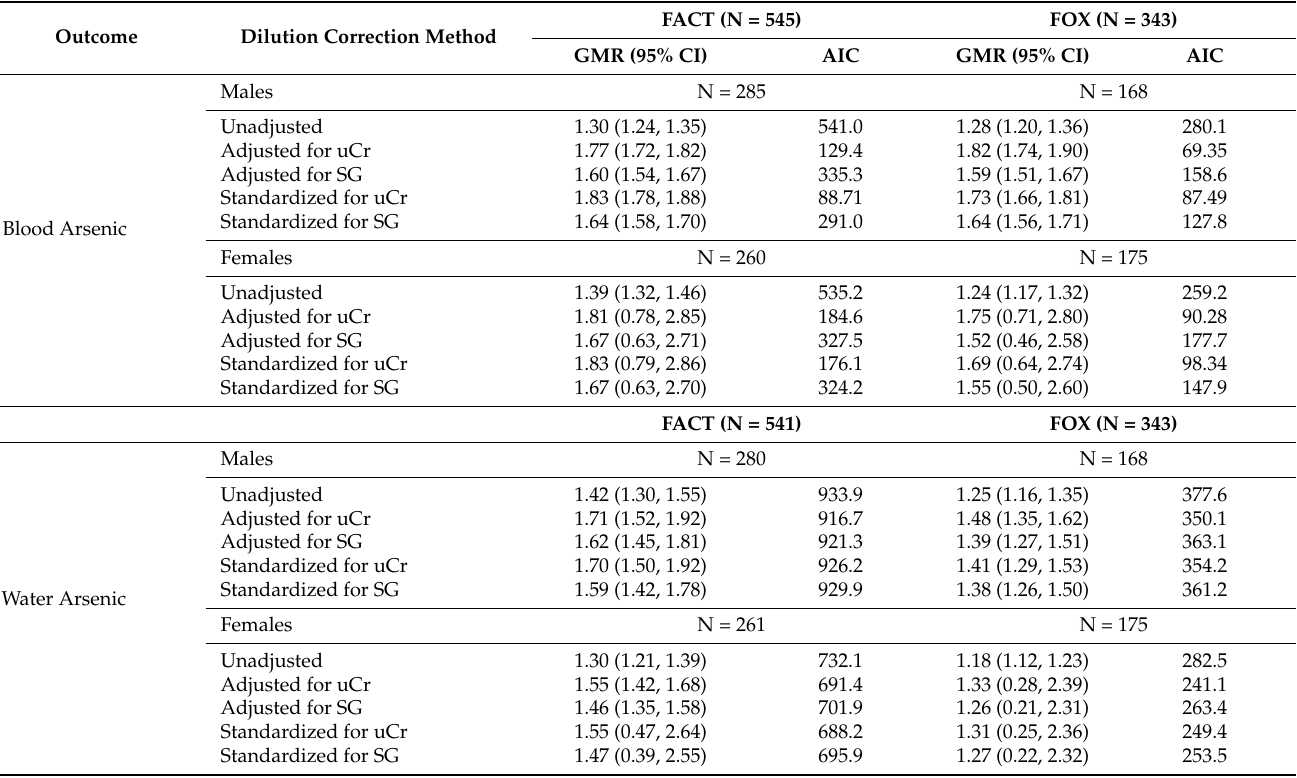
( Top and Bottom ) All models included log 2 (Total As), age, BMI, and dilution correction method (unadjusted, adjusted for log 2 (uCr), adjusted for log 2 (SG), adjusted for uAs standardized for uCr, or adjusted for uAs standardized for SG as